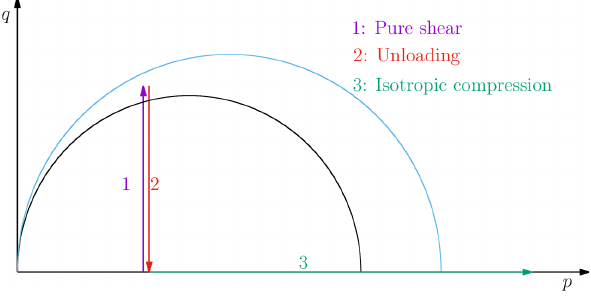
Figure 9: Loading path..